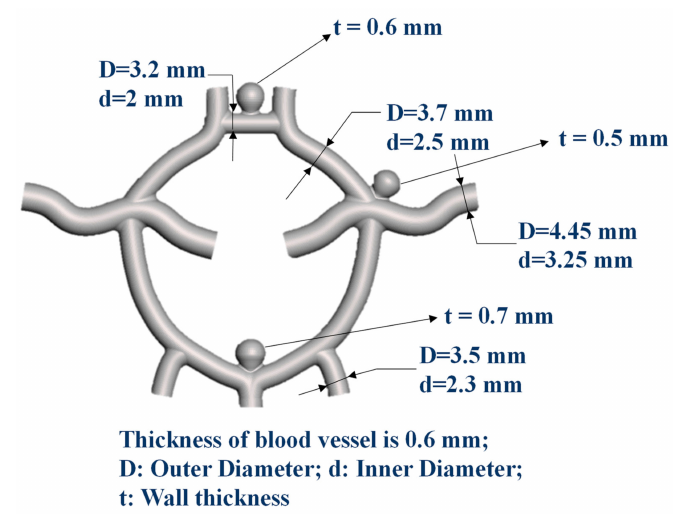
Figure 1. A layout of the Circle of Willis vascular system, showing the obvious di ff erences in the outer diameter (D), inner diameter (d), and wall thickness (t) in various locations.